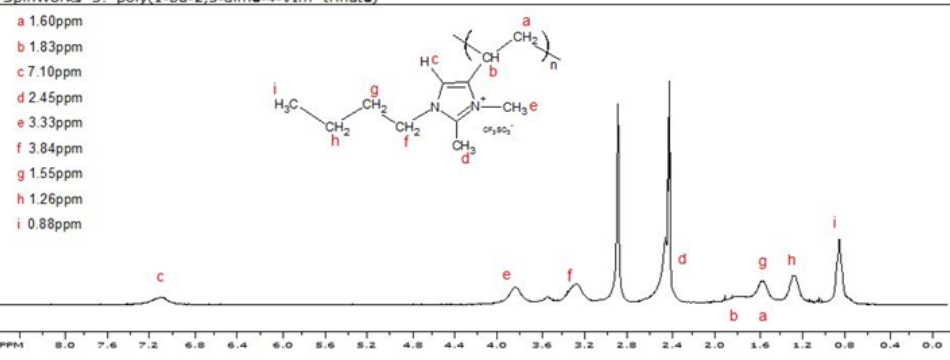
Figure 6. 1 H NMR spectrum of poly(1-butyl-2,3-dimethyl-4-vinylimidazolium triflate) . Figure 6. 1 H nmR spectrum of poly(1-butyl-2,3-dimethyl-4-vinylimidazolium triflate).